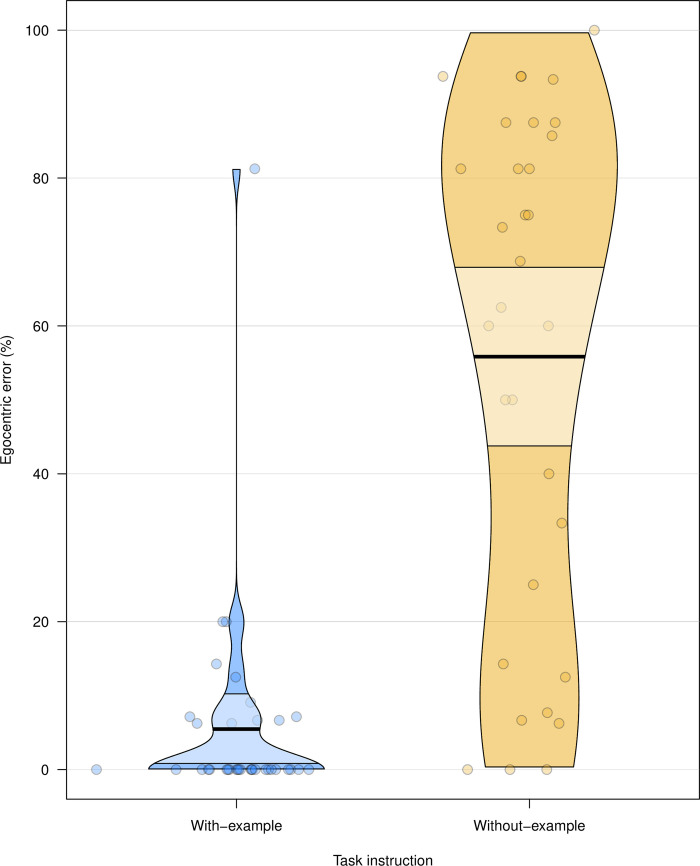
Pirate plot for the percentage egocentric errors from Experiment 1.Each circle represents the mean percentage egocentric error for a participant. The bold horizontal lines correspond to the condition means, the light-coloured bands around the means correspond to the confidence intervals.